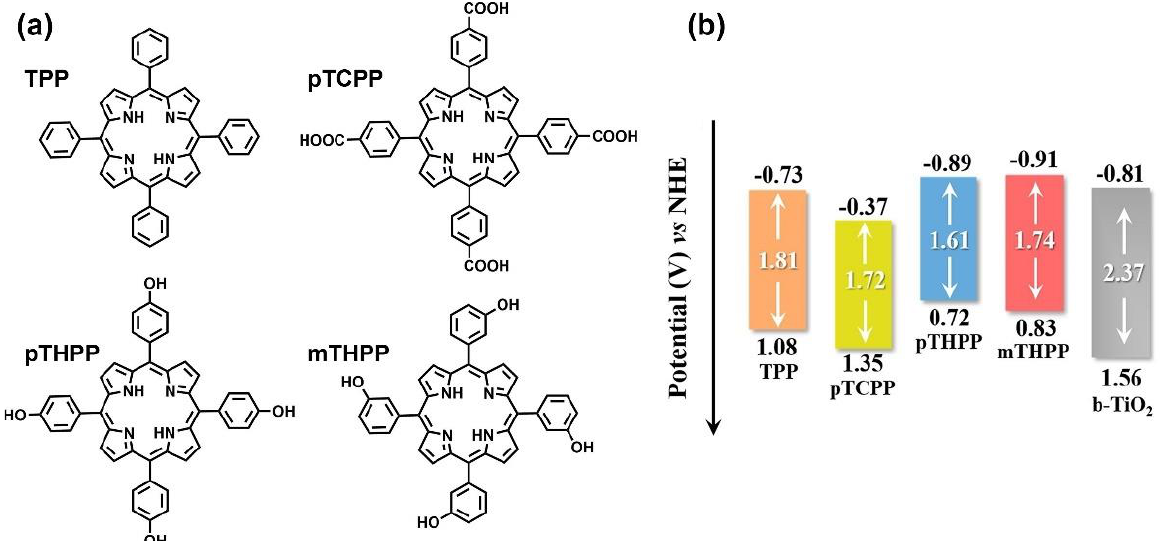
Figure 27. ( a ) Chemical structures of the porphyrin studied: meso- tetrakis(phenyl) porphyrin (TPP), meso- tetrakis(4-carboxylphenyl) porphyrin (pTCPP), meso- tetrakis(4-(hydroxyl)phenyl) porphyrin ( p THPP) and meso- tetrakis(3-(hydroxyl)phenyl) porphyrin ( m THPP); ( b ) comparison of band structure of b-TiO 2 and the four porphyrins. Adapted from reference [104] with permission from Elsevier, copyright 2022.